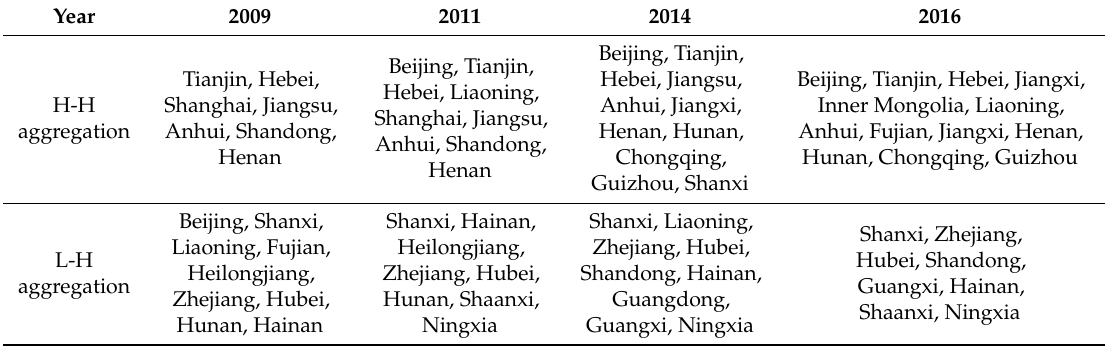
Table 5. Changes in corresponding ITE quadrants.